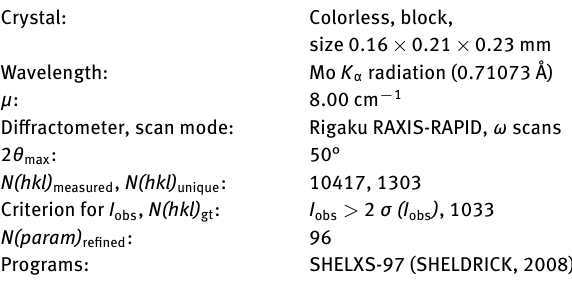
Table 1: Data collection and handling.